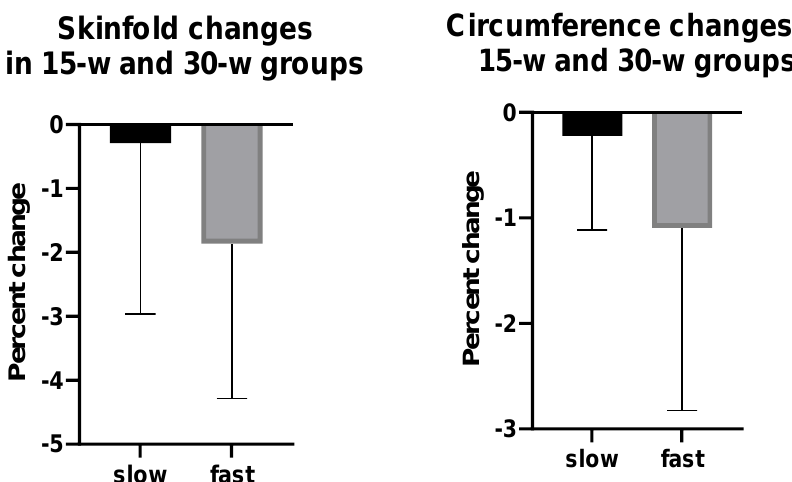
Figure 4. Skinfold and circumference percent changes in 15-week and 30-week groups.